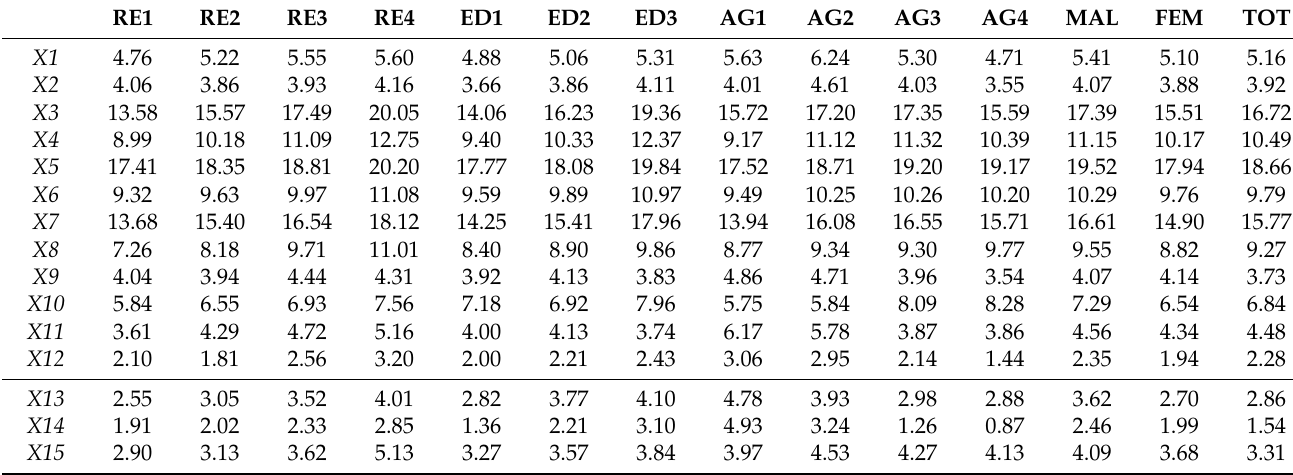
Table 5. Summary statistics—standard deviation of survey results for subcategories of consumers